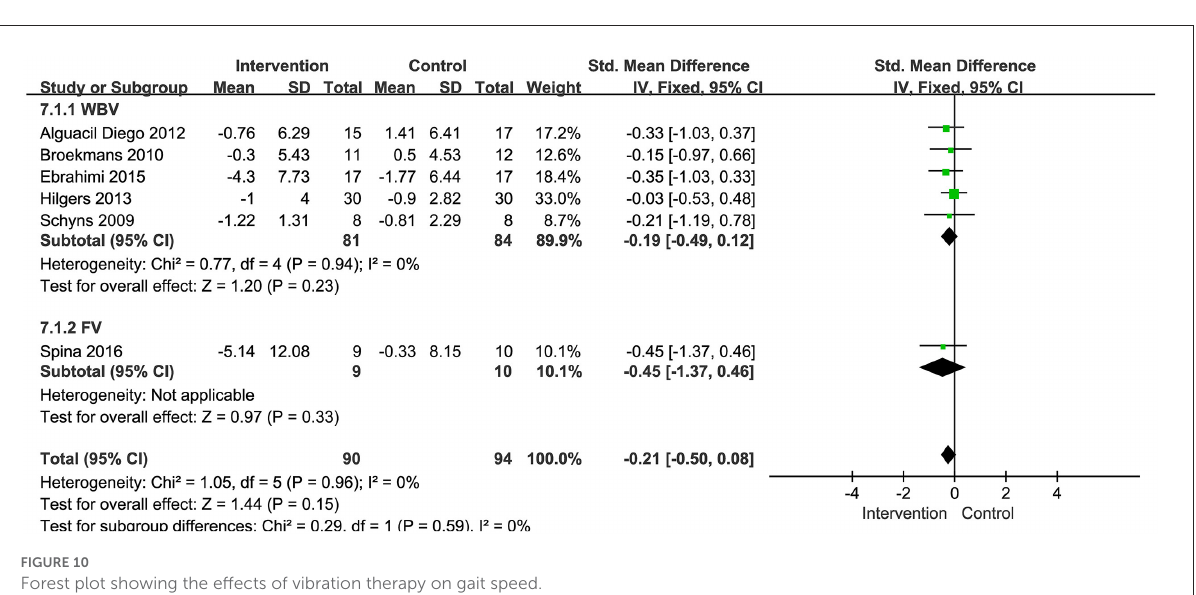
FIGURE10 Forest plot showing the effects of vibration therapy on gait